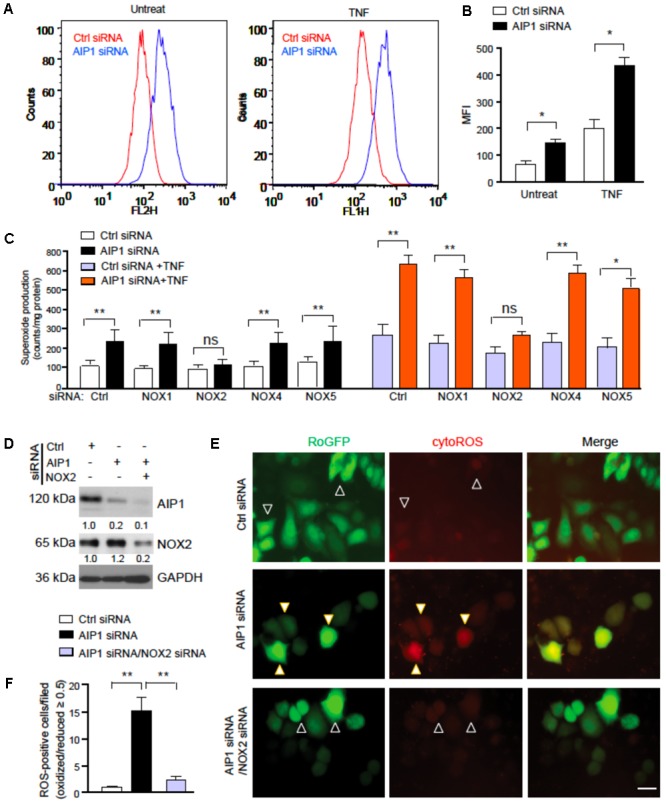
AIP1 regulates ROS generation in EC. (A,B) Human aortic EC (HAEC) were transfected with control siRNA and AIP1 siRNA. At 48 h post-transfection, cells were either left untreated or treated with TNFα (10 ng/ml for 4 h) followed by FACS analyses. Intracellular ROS were detected by flow cytometry with specific probe DHE. Representative flow cytometry histograms are shown in (A) with quantifications in (B). Data are Mean fluorescence intensity (MFI, mean ± SEM) from four independent experiments are indicated. ∗p < 0.05. (C) HAEC was transfected with control siRNA and AIP1 siRNA in the absence or presence of NOX1, NOX2, NOX4 or NOX5 siRNA. At 48 h post-transfection, cells were either left untreated or treated with TNFα (10 ng/ml for 4 h). Total NOX activity was determined by lucigenin assay. Data are presented are mean ± SEM, with n = 3. ∗∗P < 0.01. (D–F) HAEC were transfected with control siRNA or AIP1 siRNA in the absence or presence of NOX2 siRNA. 12 h later, cells were transfected with ROS reporter Cyto-roGFP plasmid. At 24 h post-transfection, living cell imaging of reduced (495 nm) and oxidized fluorescence (400 nm) were measured under fluorescent microscopy. (D) Knockdown of AIP1 and NOX2 was verified by Western blotting. Protein bands were quantified by densitometry and fold changes are presented by taking control siRNA as 1.0, n = 3. (E) Representative images for roGFP are shown. ROS-positive and ROS-negative cells are indicated by open and solid arrowheads, respectively. (F) Quantifications of cytoROS-positive cells/field. The ratio of emission from 400 (oxidized) and 495 (reduced) was calculated to determine the relative redox status of the probe in each cell. Arbitrarily, a ROS-positive cell has a ratio of oxidized/reduced fluorescence intensity ≥ 0.5 whereas a ROS-negative cell has a ratio < 0.5. Data are presented as means ± SEM, n = 6, ∗P < 0.05, ∗∗P < 0.01 using one-way ANOVA with Tukey post hoc test. Scale bar: 10 μm (E).